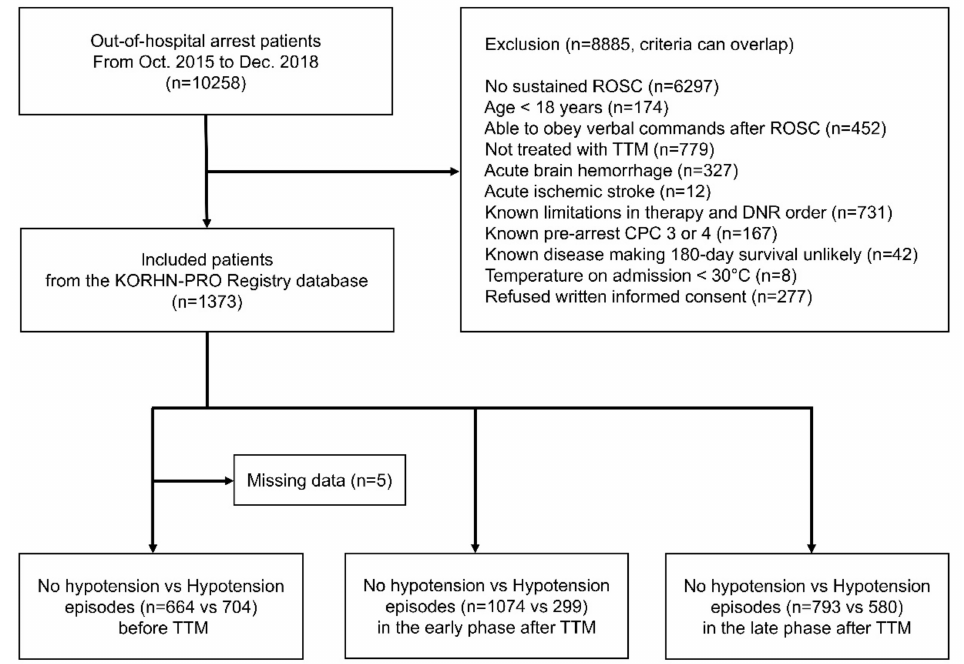
Figure 1. Screening and distribution of the patients. TTM, targeted temperature management; ROSC, restoration of spontaneous circulation; CPC, cerebral performance category; DNR: do not resuscitate; KORHN-PRO, Korean Hypothermia Network prospective